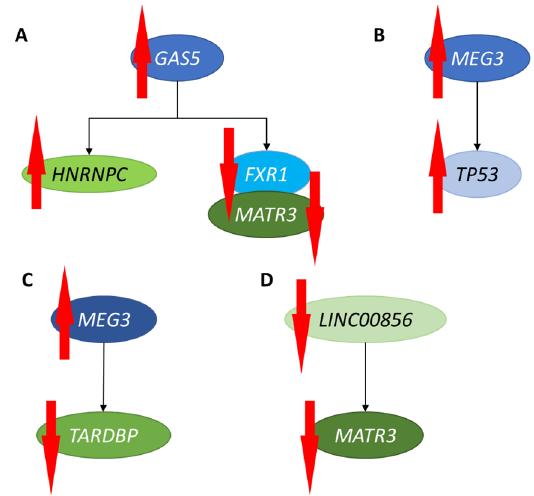
Figure 3. Correlations of increased (red, upward-pointing arrows) and decreased (red, downward- pointing arrows) levels of GAS5 ( A ), MEG3 ( B , C ), and LINC00856 ( D ) lncRNAs with significant changes (either increased or decreased abundance of mRNAs, marked by upward- or downward- pointing red arrows, respectively) in expression of specific genes in MPS cells.